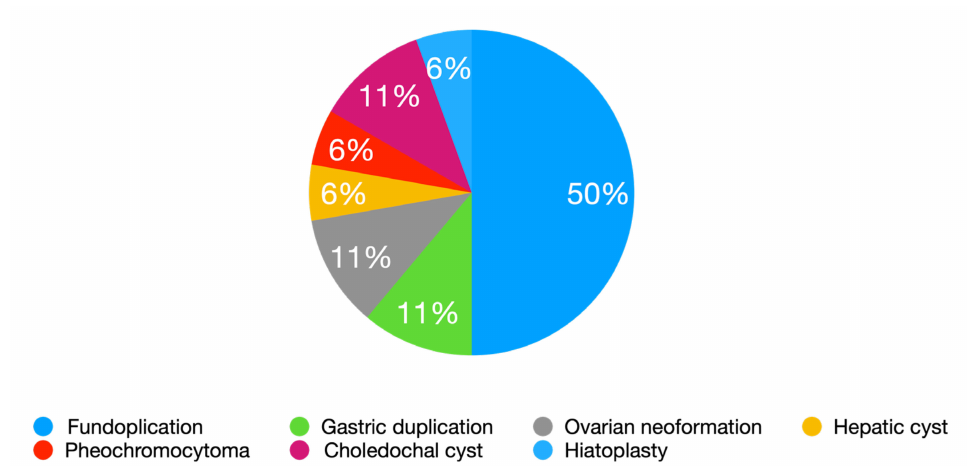
Figure 2. Major surgeries in General Abdominal Surgery.